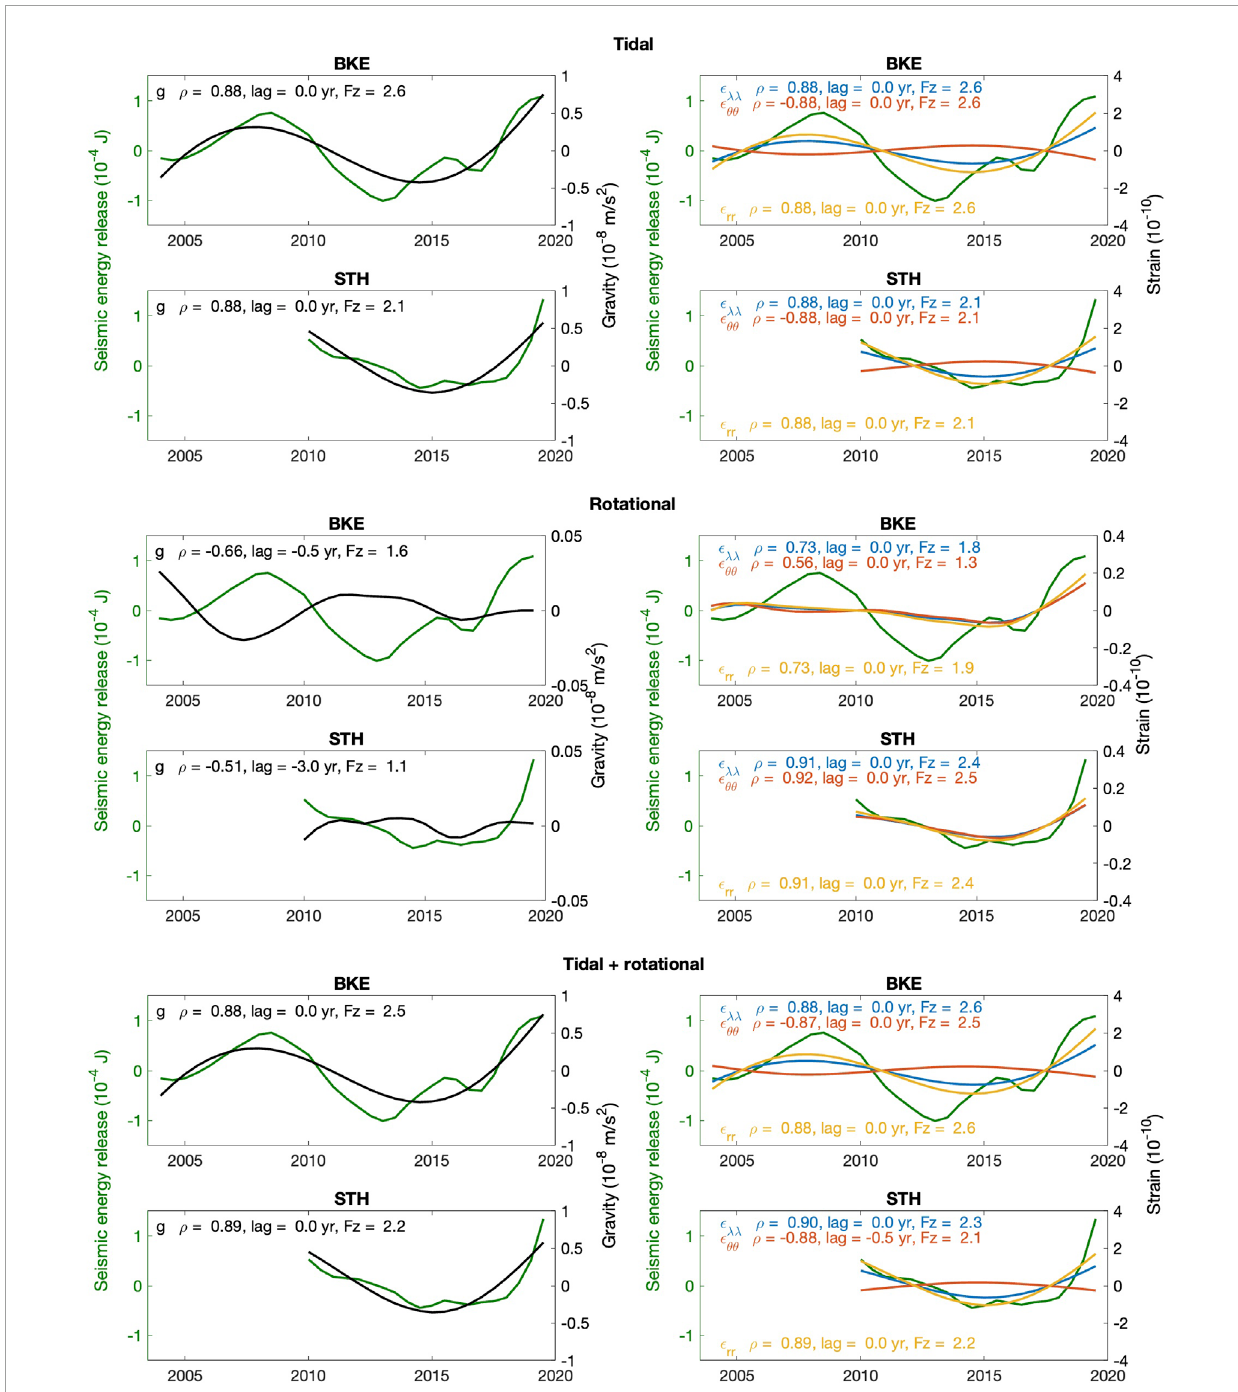
FIGURE 5 Left panels: seismic energy (in green) versus gravity variations (in black). Right panels: seismic energy (in green) versus tidal strain variations. In the right plots, ϵ λλ is the horizontal, eastward component of the surface strain tensor, ϵ θθ is the horizontal, southward component, and ϵ rr is the radial (vertical) component. In each plot, ρ is the Spearman’s coefficient and F z the Fisher’s z coefficient. A positive lag corresponds to the gravity or strain variation preceding the seismic energy